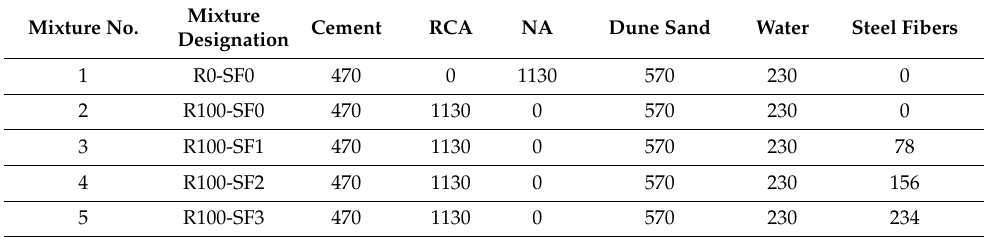
Table 2. Mixture proportions of different concrete mixtures (kg/m 3 Table 1. Physical properties of coarse aggregates.